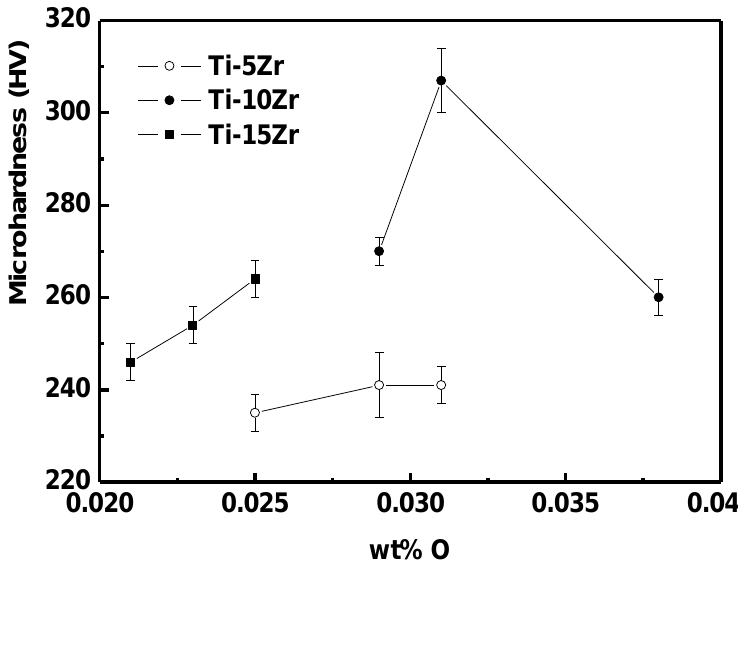
Figure 4. Microhardness as a function of oxygen content for Ti-Zr